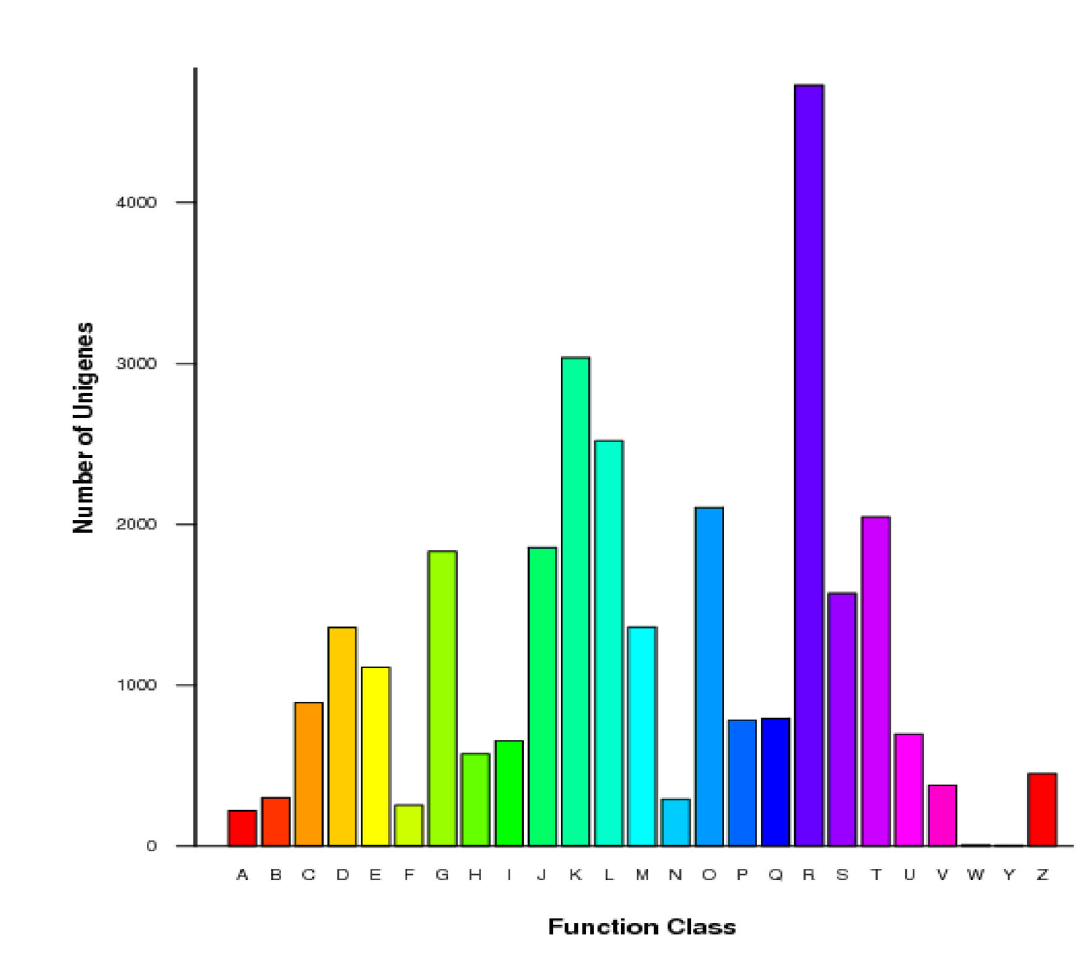
Figure 3. A histogram of clusters of orthologous groups (COG) classification. Out of 42,562 nr hits, 14,497 Unigenes have a COG classification within the 25